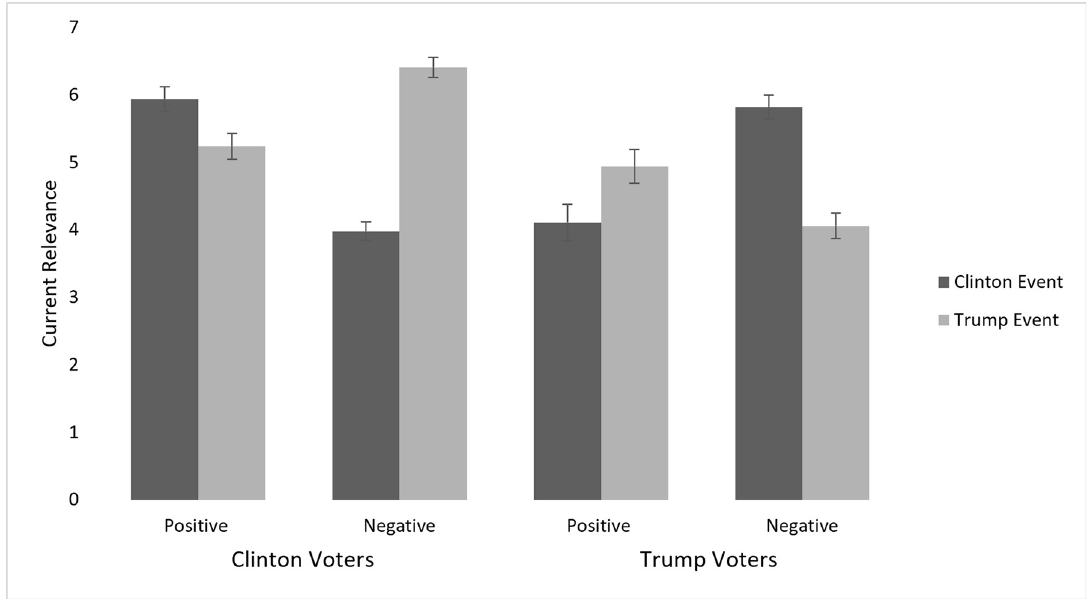
Fig 2. Relationship between voter affiliation, candidate, and event valence on current relevance. Bars represent standard